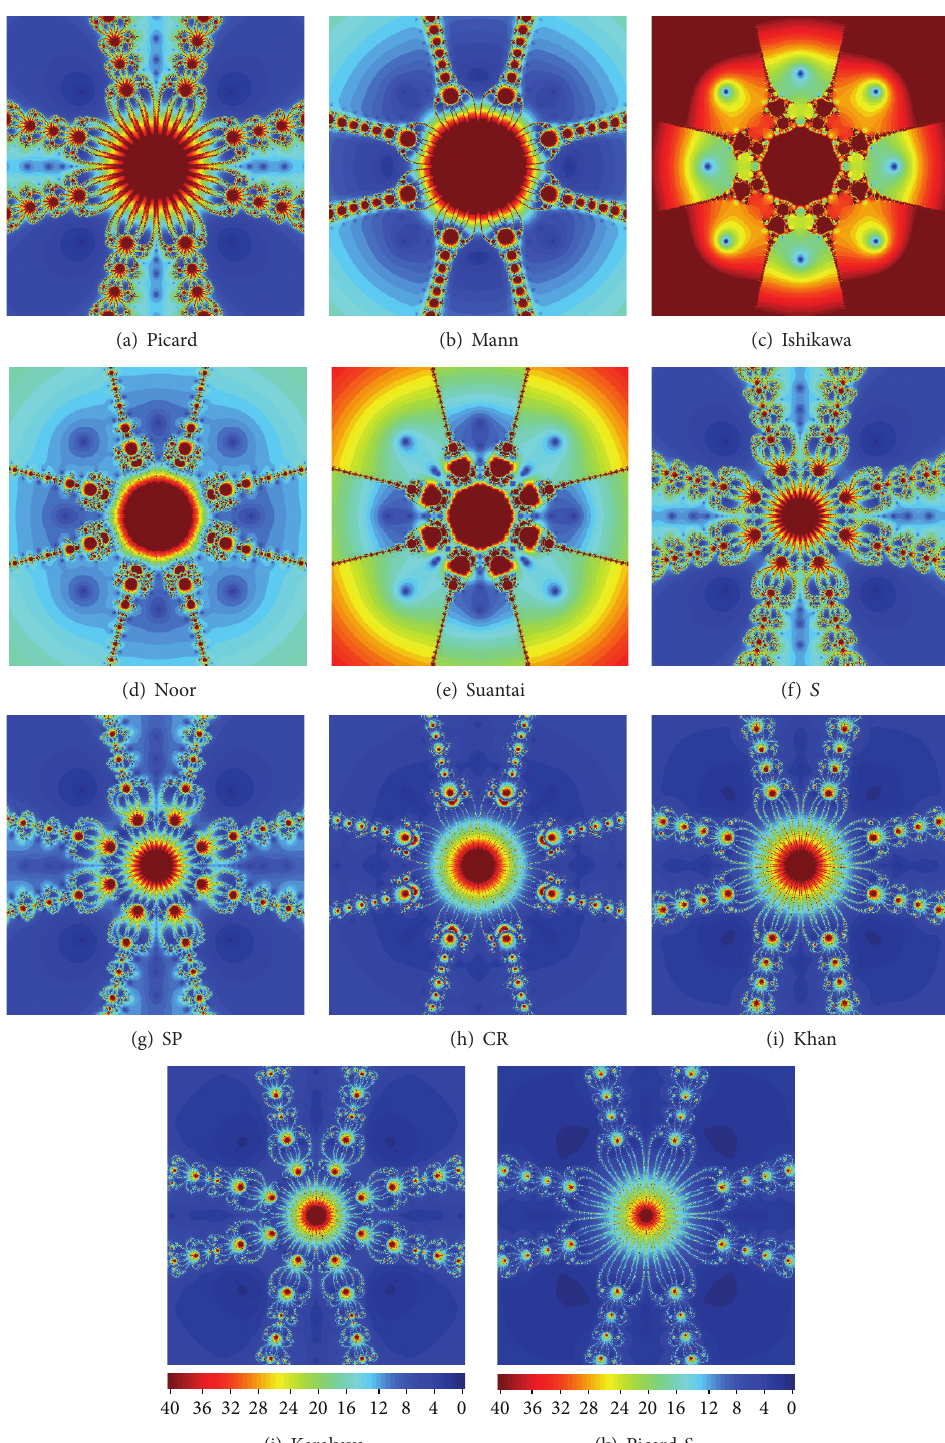
Figure 3: Examples of polynomiographs for 𝑝 2 with real-valued parameters of